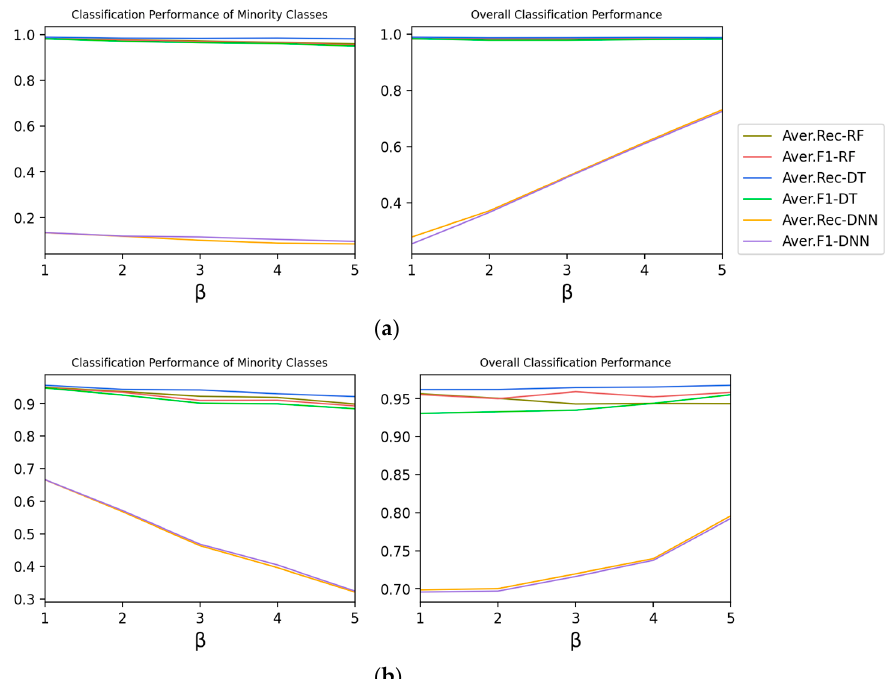
Figure 6. The effect of β on the classification performance of Type 2. ( a ) Moore Dataset; ( b ) CICIDS 2017 Dataset